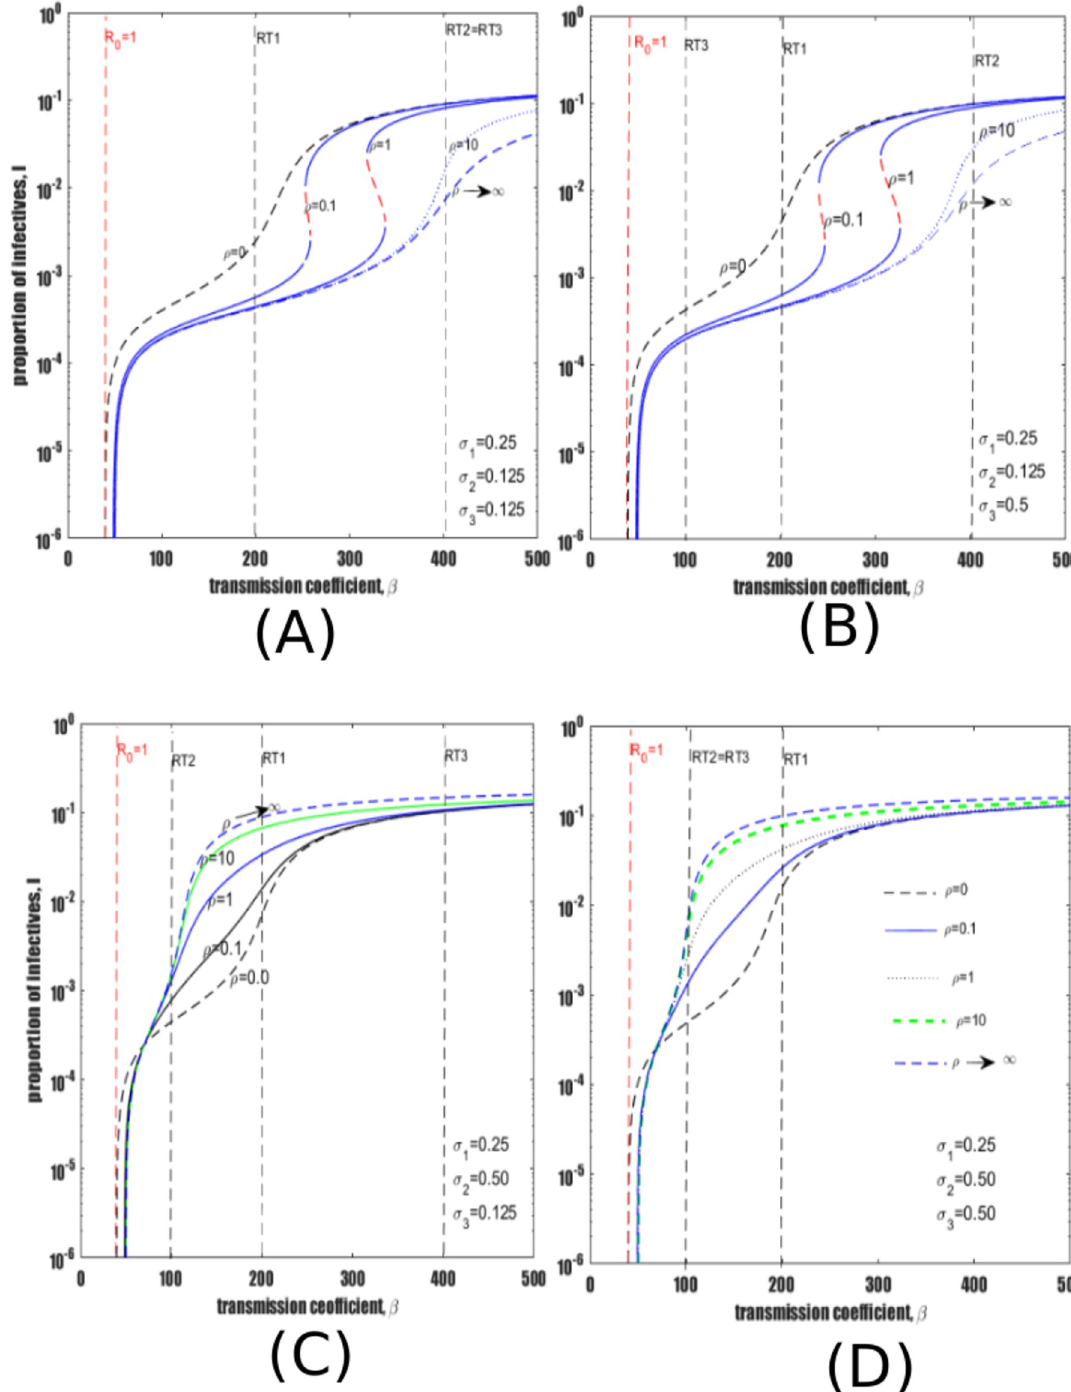
Fig 7. Effect of treatment for late latent infection under the assumption that treatment decreases (panels (A) and (B)) and increases (panels (C) and (D)) susceptibility to reinfection, and assuming that treatment for active disease decreases (panels (A) and (D)) and increases (panels (B) and (D)) susceptibility to reinfection. Treatment of individuals with active TB is fixed to τ = 2, and treatment of individuals with early latent TB is fixed to θ = 1, while treatment of late latent individuals is introduced at rates; ρ = 0, 0.1, 1, 10 and the limit ρ ! 1 . Other parameters as shown in Table 1. (A) σ 2 , σ 3 < σ 1 . (B) σ 2 < σ 1 < σ 3 . (C) σ 3 < σ 1 < σ 2 . (D) σ 1 < σ 2 , σ 3 . The black dashed endemic lines represent the baseline case where there is no treatment of late LTBI (i.e., ρ = 0) while the blue dashed endemic lines represents immediate treatment for the entire population ( ρ ! 1 ). In both figures (A) and (B) the dashed red lines of the